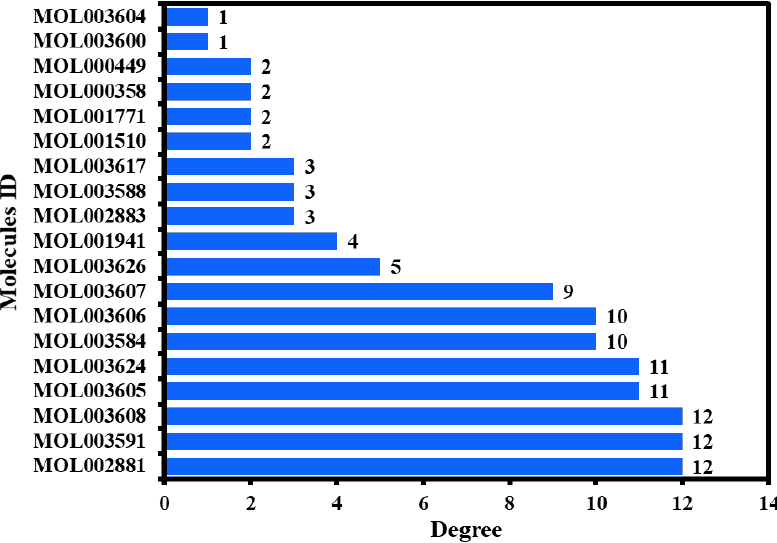
Figure 6. The 19 active phytochemicals based on their degrees in the hub network. Ranked by DC ≥ 6.025 (average value) in the hub network, the eight active phyto- chemicals acting on more than eight targets were MOL002881 (diosmetin), MOL003591 (ar-curcumene), MOL003608 (O-acetylcolumbianetin), MOL003605 [(E)-2,3-bis(2-keto-7- methoxy-chromen-8-yl)acrolein], MOL003624 (O-isovalerylcolum bianetin), MOL003584 (xanthoxylin N), MOL003606 (cniforin A), and MOL003607 (cniforin B) (Figure 6). These eight active phytochemicals are considered the most important and key active phyto- chemicals found in Cnidium monnieri for HCC treatment. The network findings reveal that a single phytochemical may interact with multiple HCC targets, and multiple